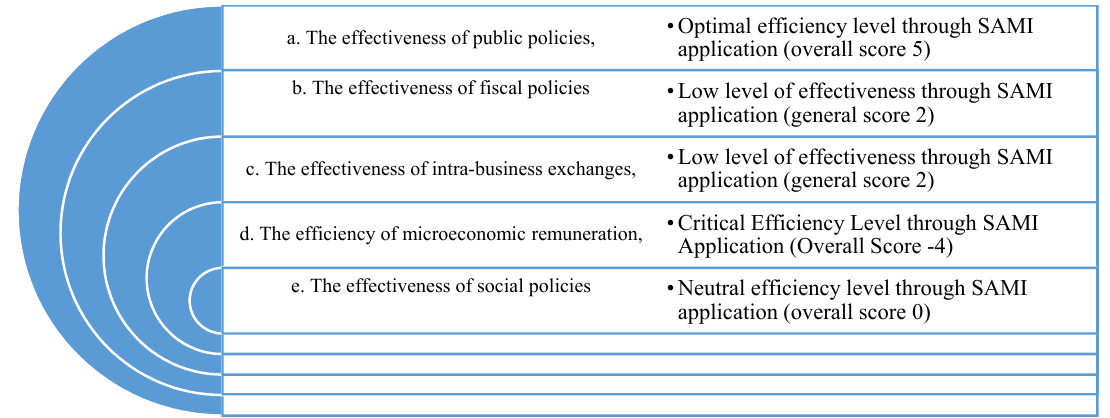
Figure 7. SAMI’s scheme developed by the authors.